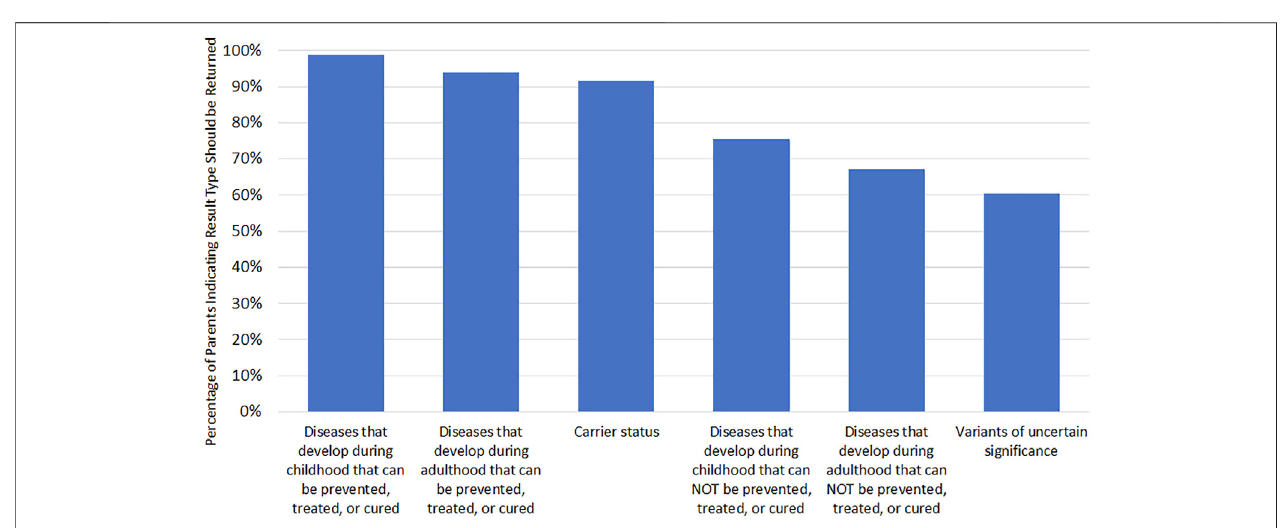
FIGURE 1 | Attitudes toward results types to be returned to parents if every newborn received GS. Only asked if parent agreed or strongly agreed that every newborn should receive GS ( n = 167). Respondents could select multiple options.